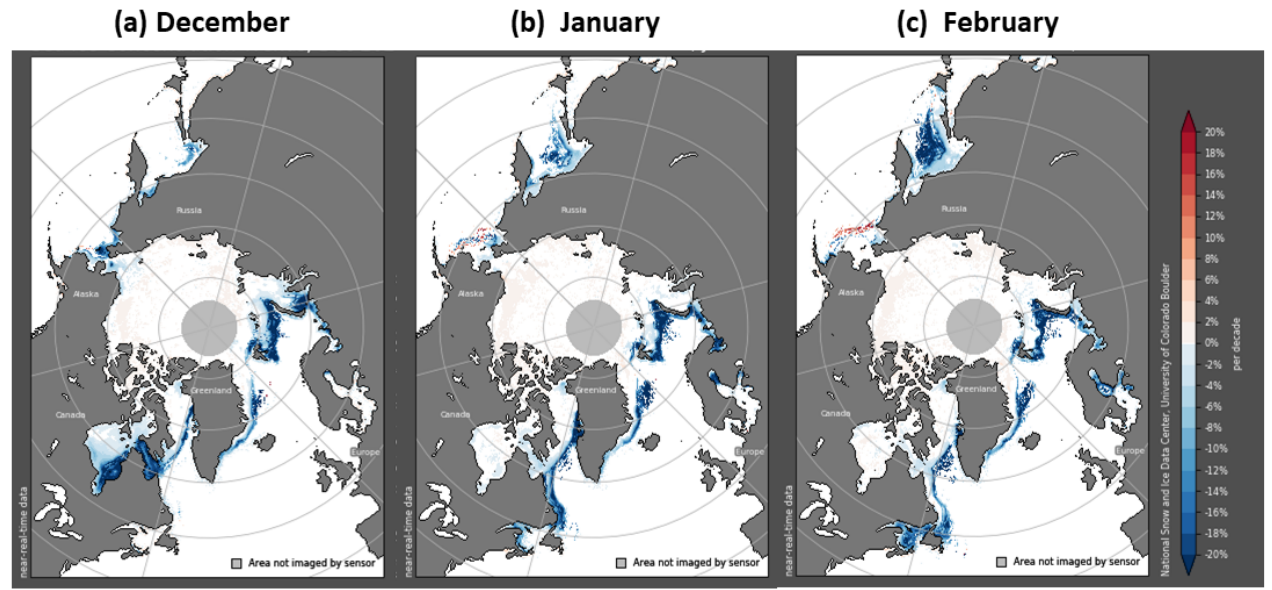
Figure 4. Trends sea ice concentration (fractional sea ice coverage) for ( a ) December 1979–2021, ( b ) January 1979–2022 and ( c ) February 1979–2022. Color bar on the right shows percentage changes from the start to end of the period (blue shades are decreases, red shades are increases). Source: National Snow and Ice Data Center dataset G02135, https://nsidc.org/data/seaice_index/compare_trends (accessed on 20 March 2022).